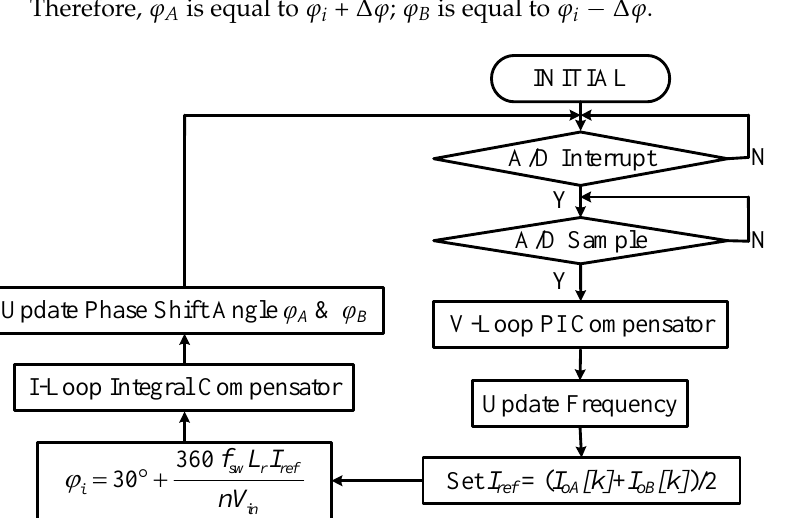
Figure 10. Main control flow chart. (A/D: analog to digital; I oA [k] : digital value of i oA ; I oB [k] : digital value of i oB ; I ref : reference current; PI: proportional-integral controller; f sw : switching frequency; L r : resonant inductor; n : turn ratio of the primary-side to the secondary-side of the transformers; V in : input voltage; ϕ A : phase shift degree of ModuleA; ϕ B : phase shift degree of ModuleB).